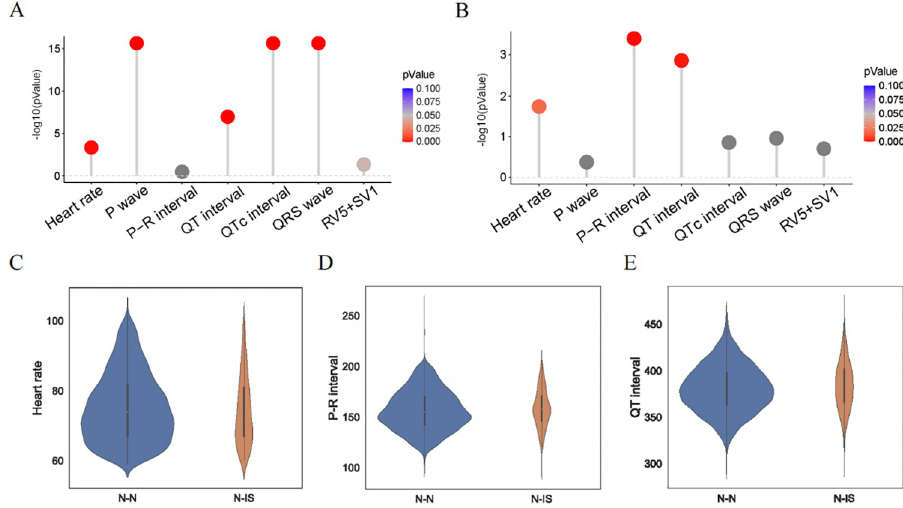
Fig 2. Analysis of participant ECG parameters. (A) P values for the seven ECG parameters between the A-IS and N-N datasets (Wilcoxon rank-sum test). (B) P values for the seven ECG parameters between the N-IS and N-N datasets (Wilcoxon rank-sum test). (C) Heart rate (bpm) distribution of the N-N and N-IS datasets. (D) P-R interval (ms) distribution of the N-N and N-IS datasets. (E) QT interval (ms) distribution of the N-N and N-IS datasets.